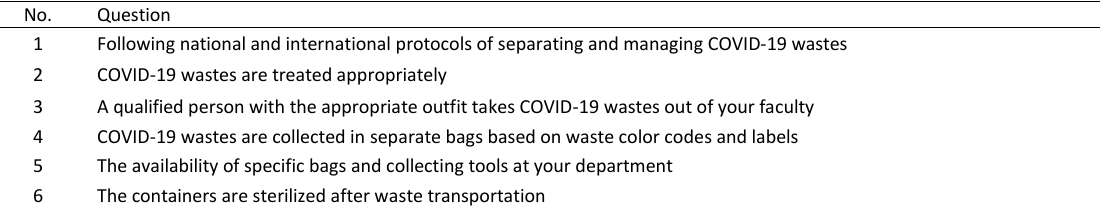
screening stations